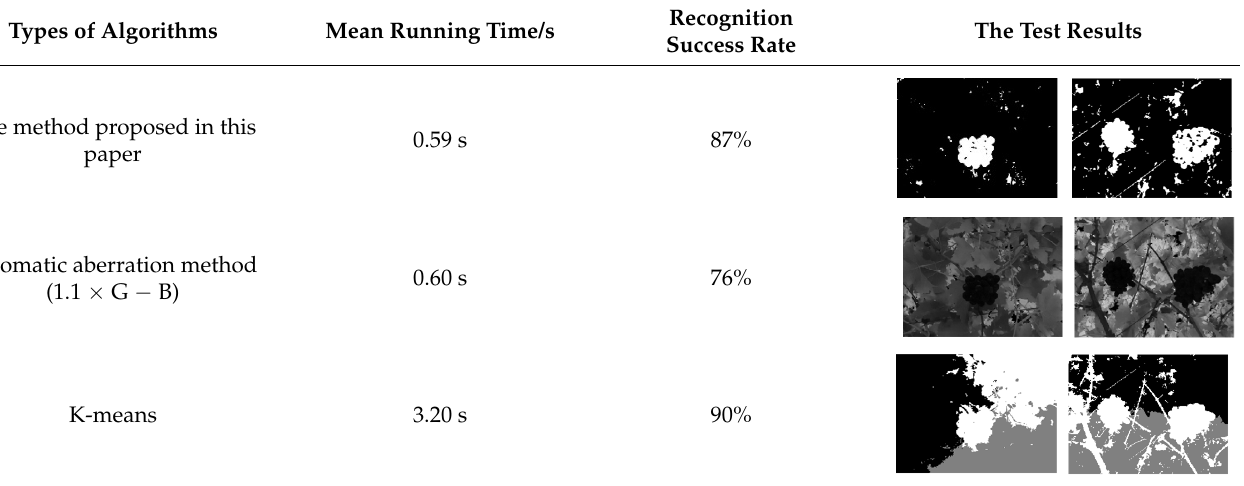
Table 1. Comparison of multiple methods.